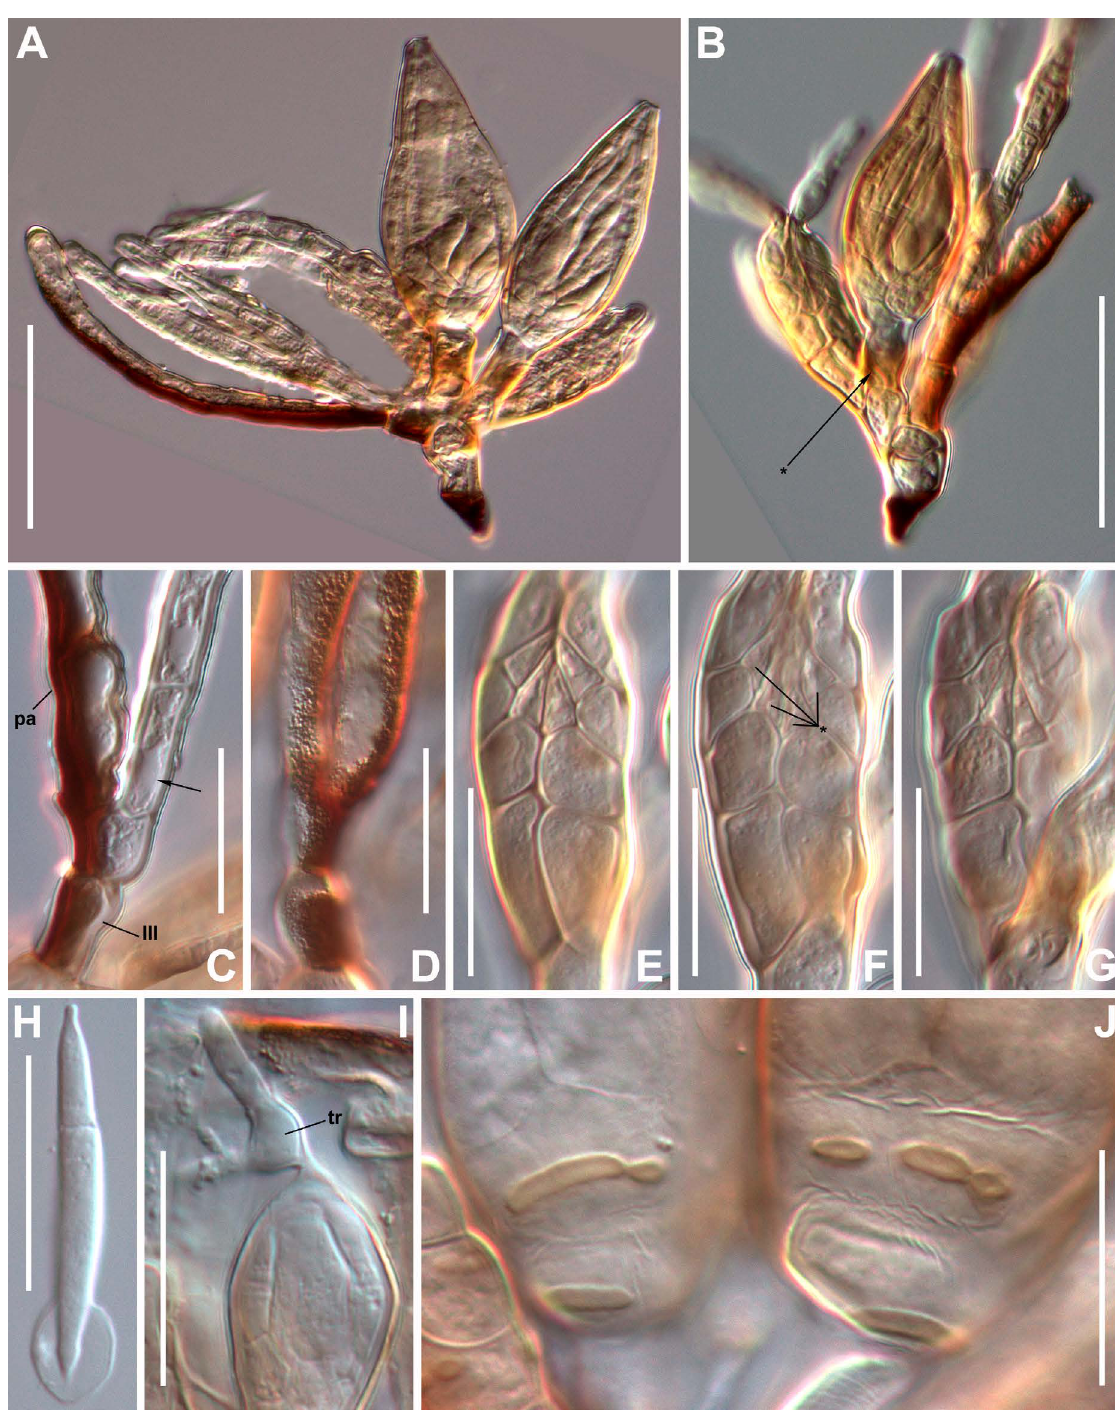
Fig. 81. Monoicomyces brachiatus Santam. sp. nov. A – B . Mature thalli. In B, “*” points to the narrowing and darkening lower half of cell VI. C . Primary appendage (pa) and additional branch (arrow) arising from cell III in detail. D . Delicate surface roughness of appendage in detail. E – G . Respectively, far, middle and near focus of antheridium in detail. In F, the asterisk * points to the four phialides. H . Ascospore. I . Young perithecium and trichogyne (tr) in detail. J . “Stigmata” in the lower area of two perithecia. Scale bars: A–B = 50 µm; C–J = 20 µm. Photographs from slides ZMUC C-F-123004 (A) (holotype), ZMUC C-F-122477 (B–C), ZMUC C-F-123759 332